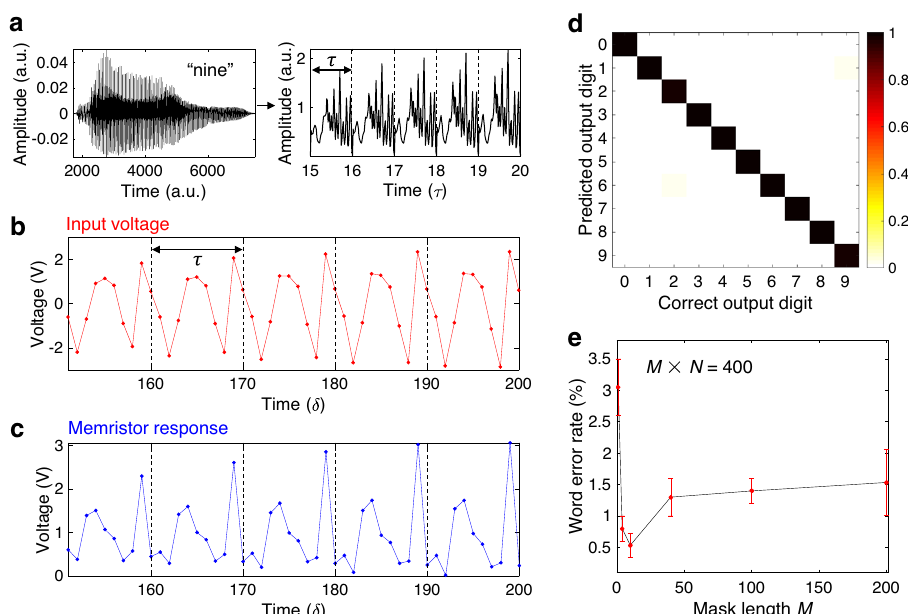
Fig. 3 Spoken-digit recognition demonstration. a Left: typical audio waveform of digit 9 pronounced by a female speaker. Right: cochlear spectrum (64 channels per frame) of the corresponding audio waveform. The channel values for each frame are transferred to the time domain with a duration of τ . b Time multiplexing process. In each interval of duration τ , the spectrum signal is multiplied by a mask matrix (64 × M ) containing randomly assigned binary values ( − 1 and 1) to generate the input voltage sequence with a fi xed time step δ ( δ = 120 μ s) equal to 1/ M of τ , where M is the mask length. The similar process repeats by N times with different mask matrices in order to mimic N -parallel RC system. c During each time duration, the dynamic memristor response is recorded. The device current is fi rst converted into voltage through the load resistor and then ampli fi ed and collected by the ampli fi er and ADC. After that, the N times memristor responses in each duration of τ are combined into the reservoir states for subsequent classi fi cation. d Predicted results obtained from the memristor-based RC system versus the correct outputs, where the word error rate is as low as 0.4%. The two parameters M and N of the RC system are set to be 10 and 40, respectively. Color bar represents the normalized probability of each predicted result under the correct output. e Word error rate as a function of the mask length M , where the total reservoir size ( M × N ) remains constant at 400. Similar to the waveform classi fi cation task, the average of word error rate reaches the lowest value when M = 10. The error bar represents the variation between